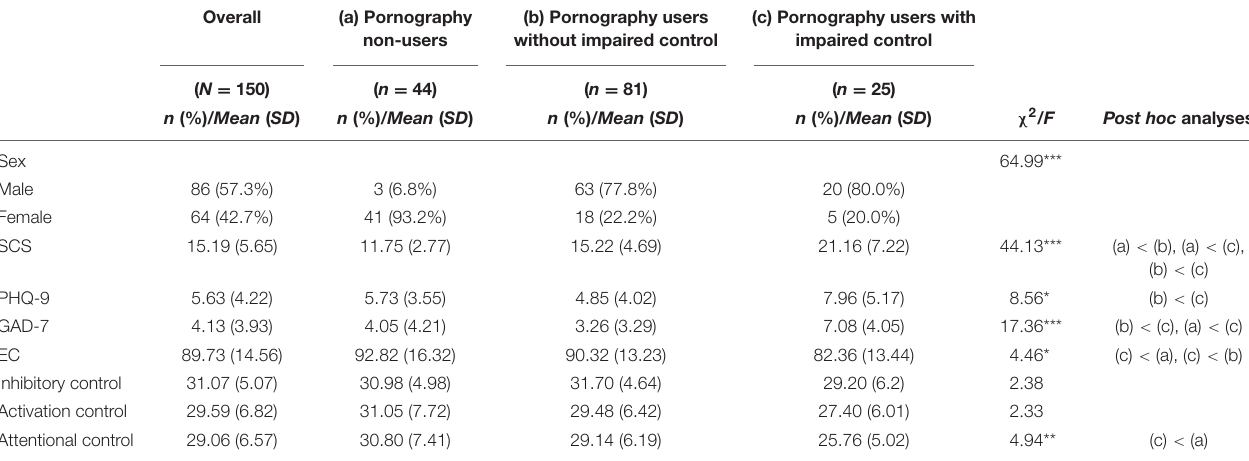
TABLE 2 | Comparison between pornography non-users, pornography users without impaired control, and pornography users with impaired